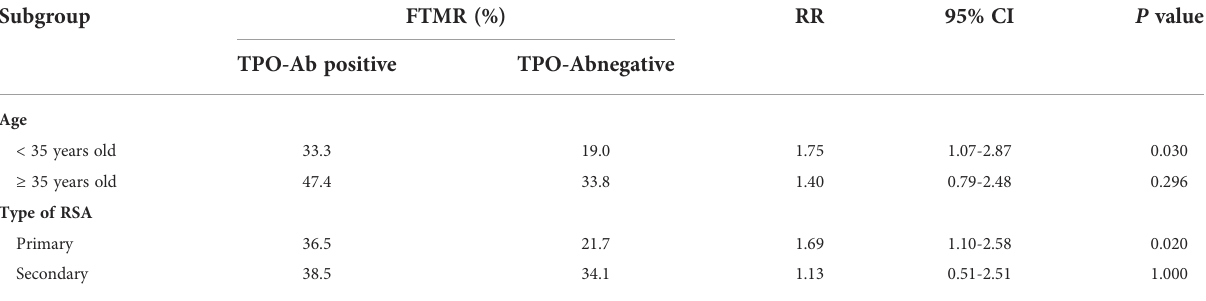
TABLE 3 Subgroup analysis of age and types of RSA for FTMR in euthyroid women with URSA. Subgroup